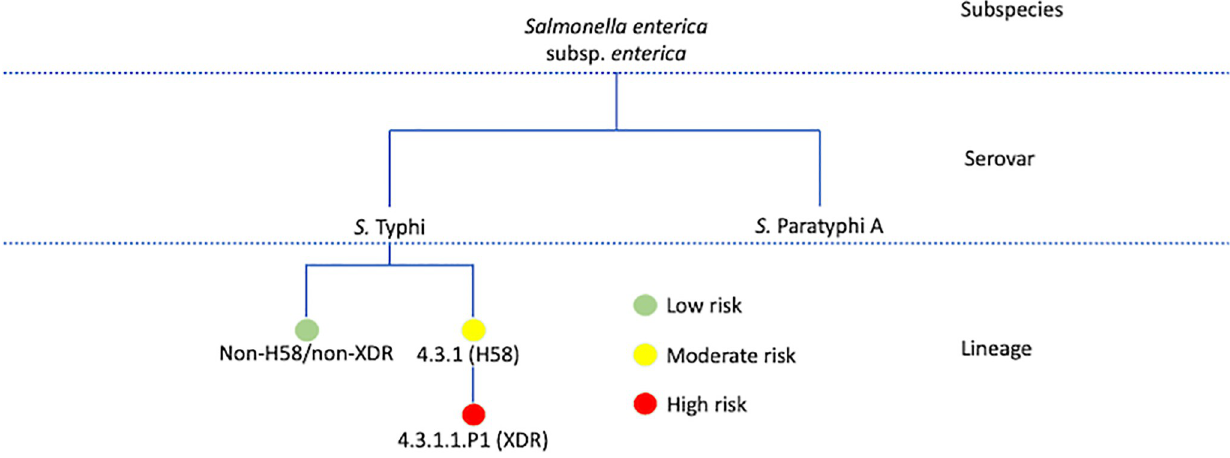
Fig 1. The developed SNP-based multiplex PCR assay detects Salmonella species and offers greater resolution down to lineage specific level. Current routine diagnostics can only offer a resolution to species or serovar level. From the data obtained through whole genome sequencing, our targets for this PCR assay can identify specific lineages of S . Typhi that can be of clinical